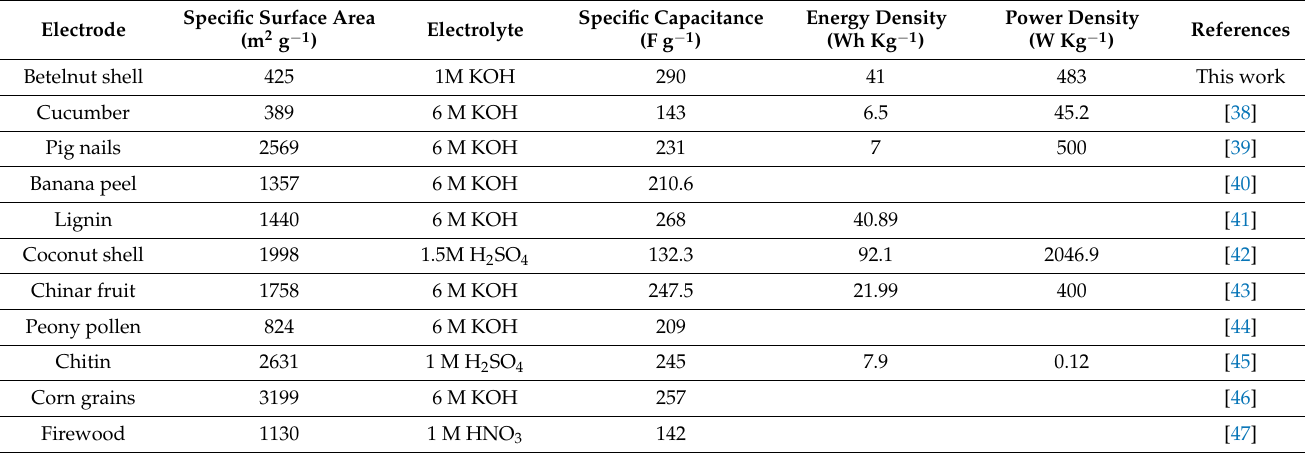
Table 1. The comparison of various biomass-derived carbon materials and their supercapacitive performance in the literature.